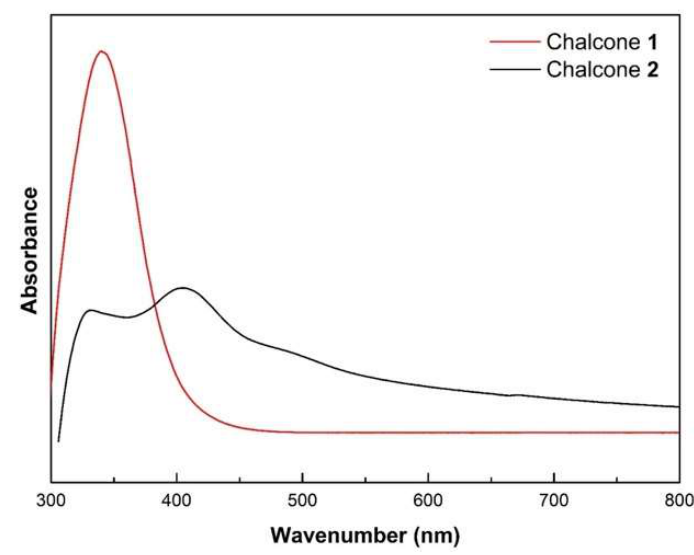
Figure 5. UV-Vis experimental spectra of chalcones 1 and 2 in ethanol solution.